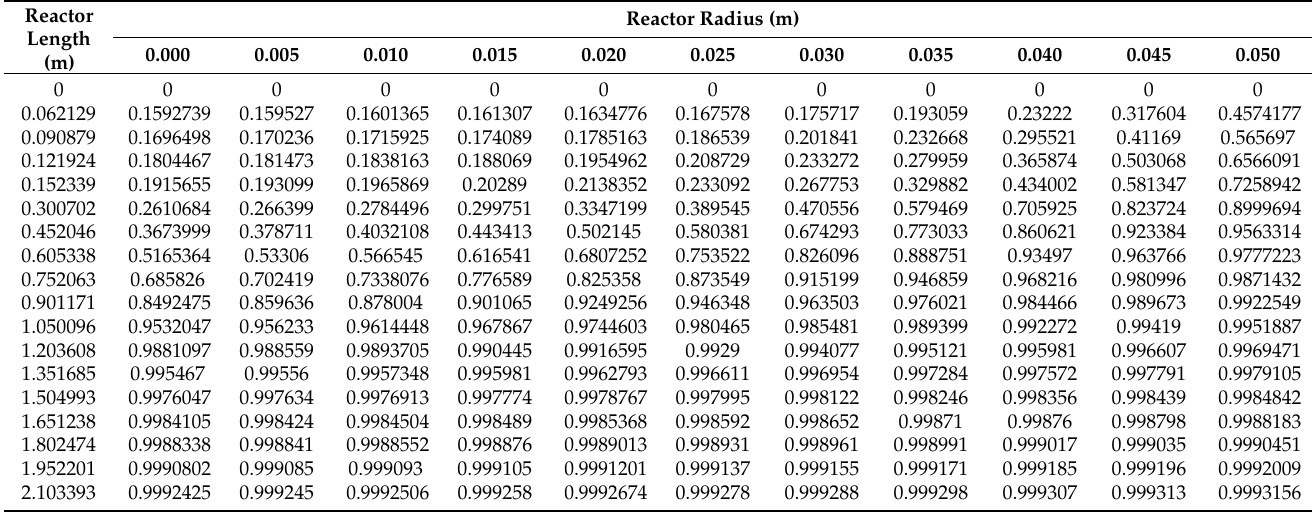
Table A1. Results of the simulation of the external conversion conditions in the catalytic bed as a function of the length and radius of the reactor. Obtained from the execution of the program reactor.pol .